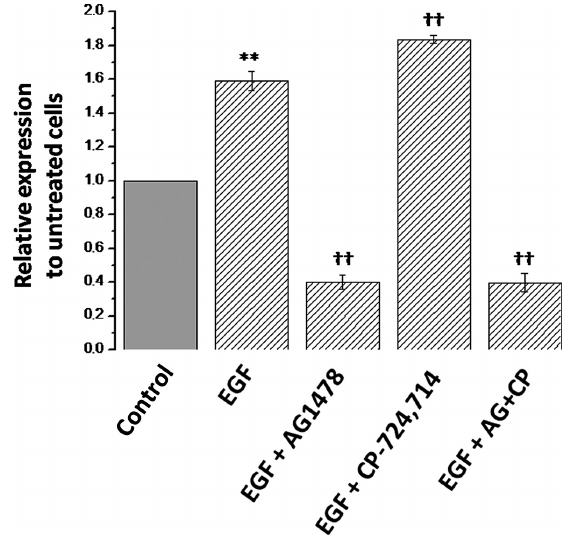
Figure 1. The effect of EGF on gene expression of EGFR in DLD-1 colon cancer cells. The mRNA levels were assessed by RT-PCR analysis. Cancer cells were fi rst preincubated with AG1478 (1 μΜ ) and CP-724,714 (1 μΜ ) for 30 min, followed by the intro- duction of EGF (20 ng/mL). Total incubation time was 24